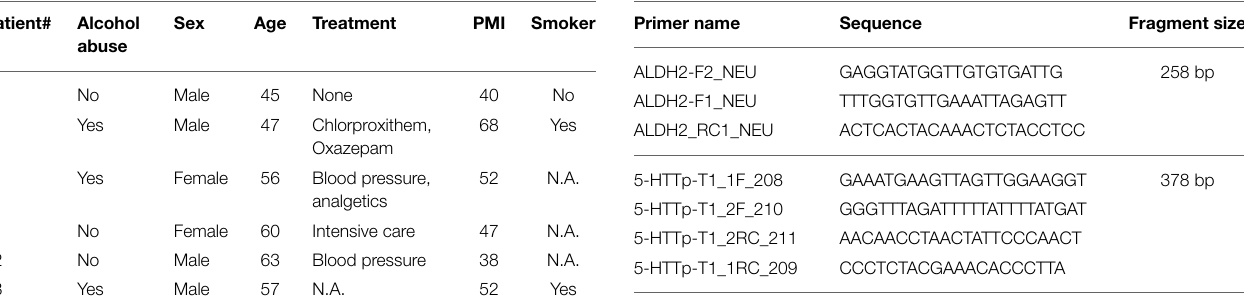
TABLE 2 | Biometrical data for the human collective that was investigated. TABLE 3 | Primers used for the Touchdown